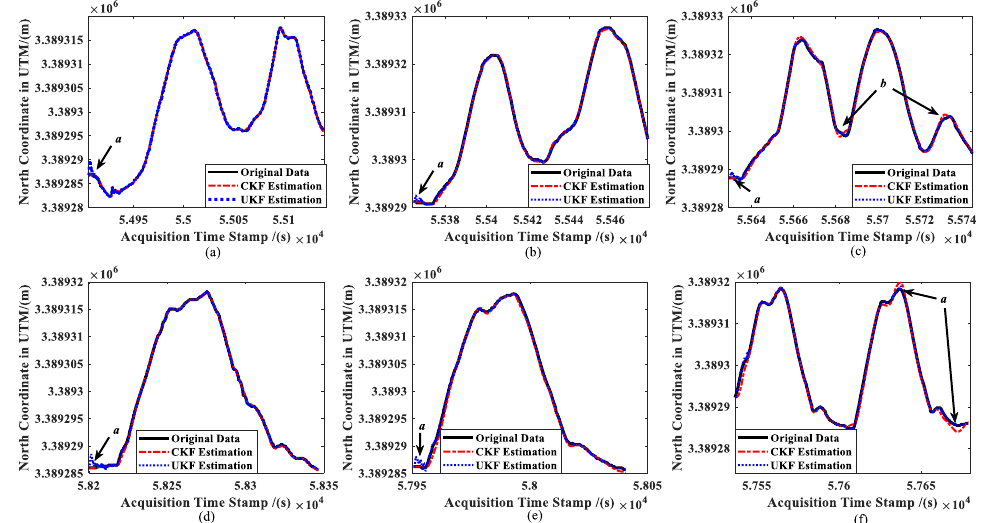
Figure 7. Comparison of ship position estimations: ( a ) slow speed of MRM, ( b ) medium speed of MRM, ( c ) high speed of MRM, ( d ) slow speed of ANM, ( e ) medium speed of ANM, and ( f ) high speed of